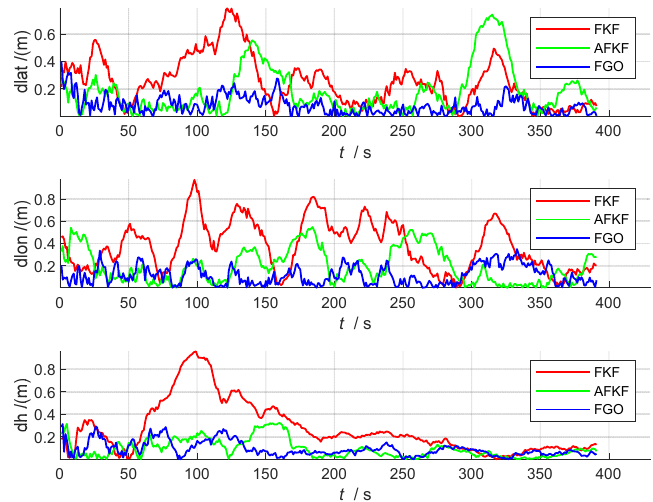
Figure 10. Comparison of position errors of different algorithms.